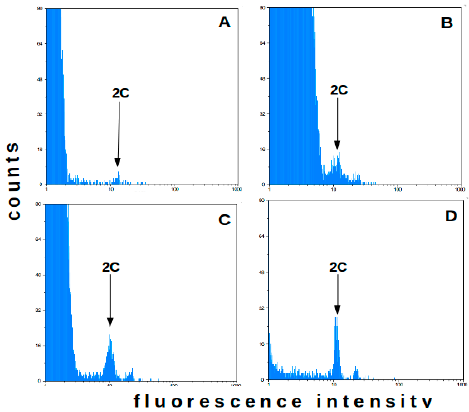
Figure 1. Flow cytometry histograms for A. linearis leaves from 3 weeks-old commercial rooibos seedlings using Partec buffer ( A ), LBO1 10X Triton X-100 buffer ( B ), LBO1 5X Triton X-100 ( C ), and Woody Plant Buffer ( D ). Sample 2C (GO/G1 phase) peaks are shown ( n = 10).